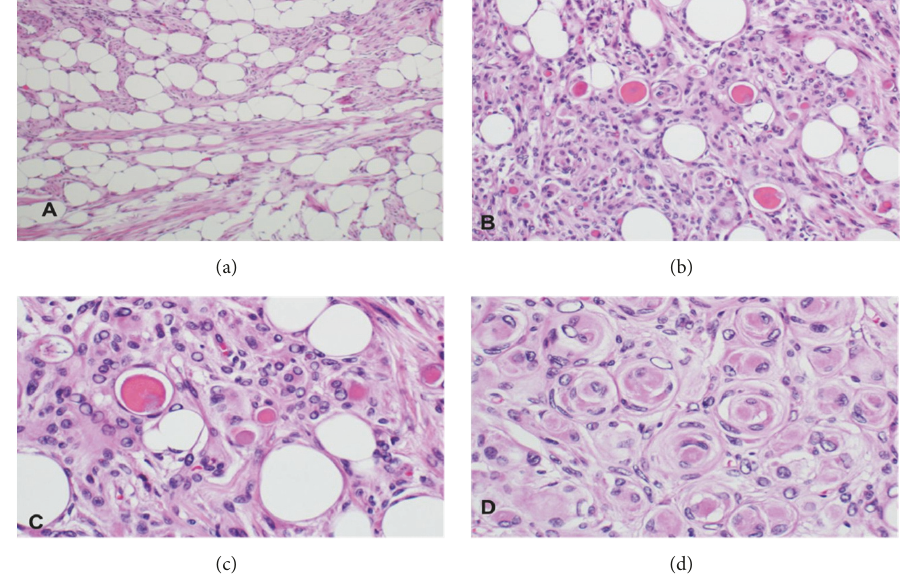
Figure 2: Hematoxylin and eosin stain of the tumor tissue. (a) x100 magnification showing mature adipose tissue intermingling with meningotheliomatous components. (b) x200 magnification demonstrates meningotheliomatous secretory and adipose components. X400 power view of the hyaline inclusion bodies (c) and whorls of the classic meningioma